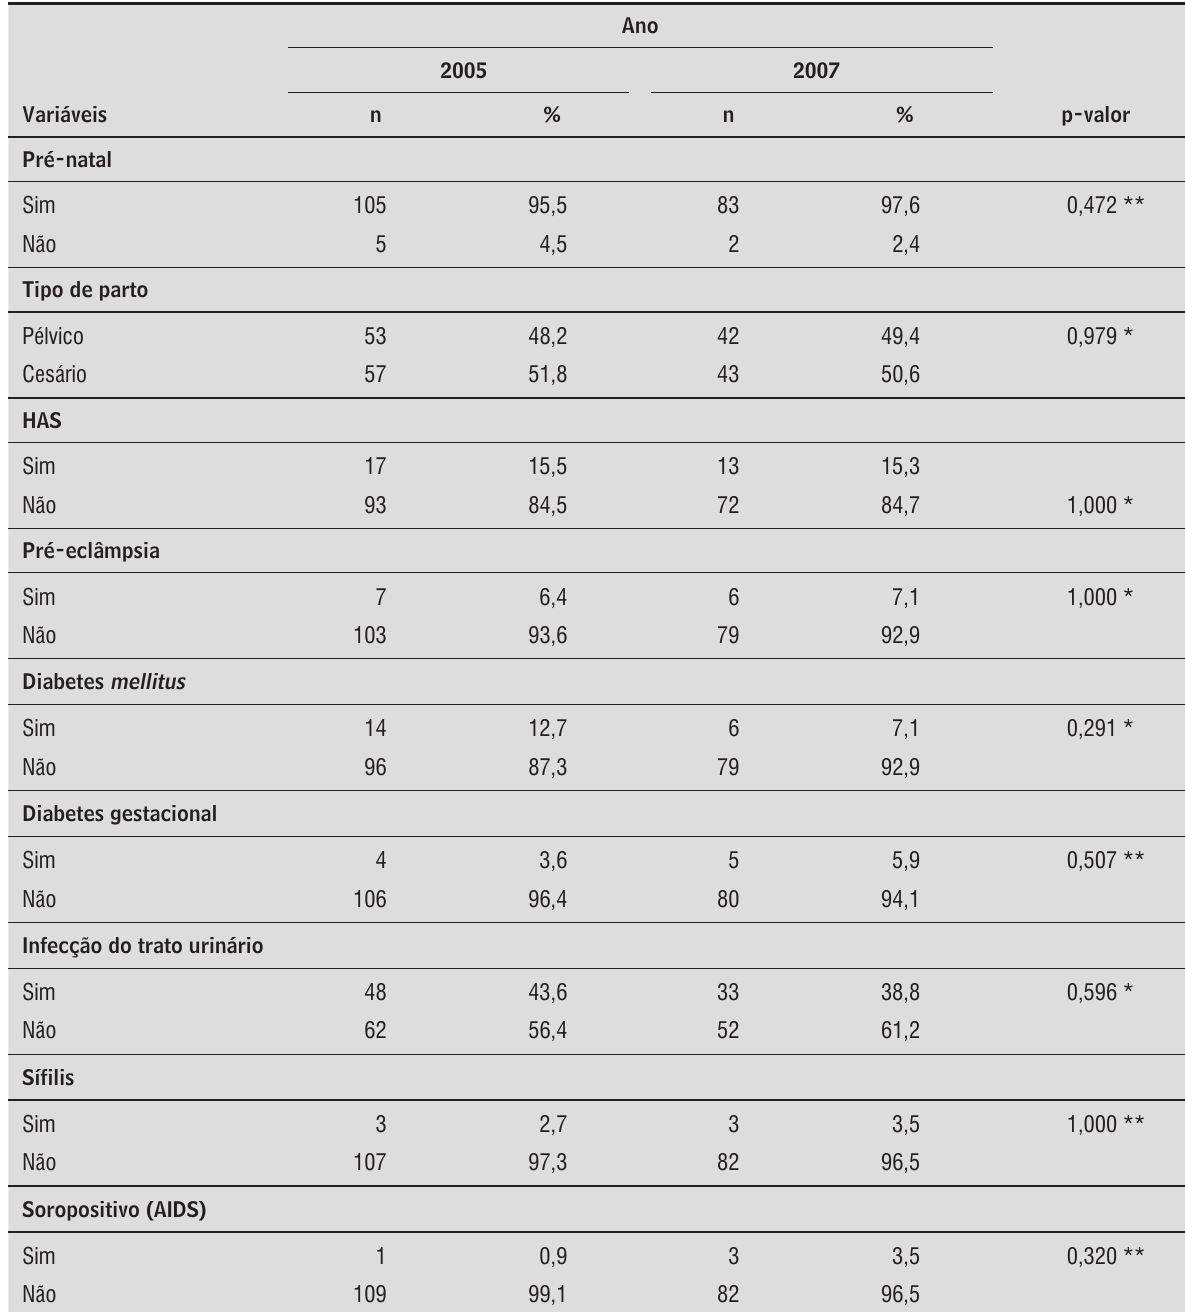
Tabela 1 - Dados maternos dos recém-nascidos internados na unidade de terapia intensiva neonatal do Hospital Agamenon Magalhães em Recife, PE, no período de janeiro a dezembro de 2005 e 2007